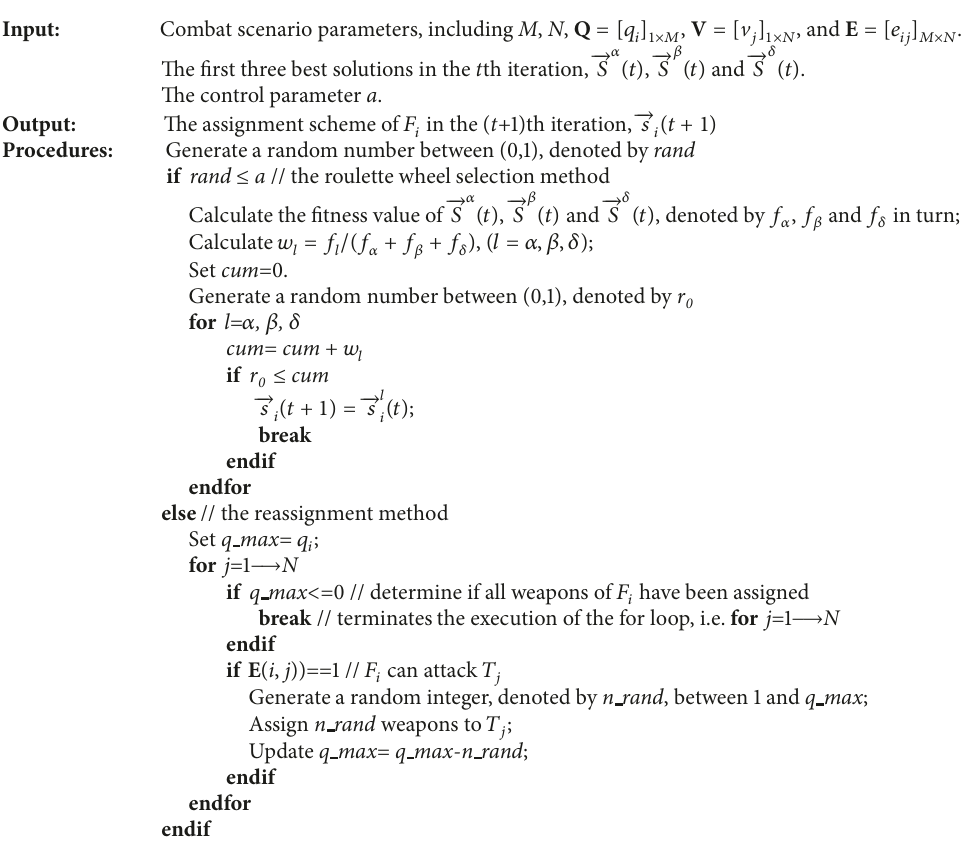
Algorithm 2: Pseudo-code of the modular position update method.